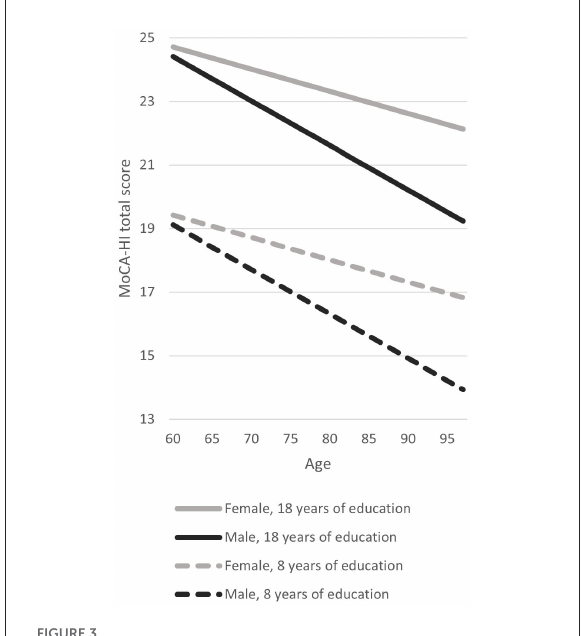
FIGURE3 Example regression lines for the whole study sample ( n = 175) representing the relationship of MoCA-HI total score with age, education and sex. Example regression lines are shown for subjects with 8 and 18 years of education. The regression model shows that the MoCA-HI total score was lower in case of less educational years, an increasing age and in male sex. Age had a stronger effect on the MoCA-HI total score in men than in women. 100 of the subjects included were aged between 60 and 71 years (males n = 59, females n = 41), 60 subjects between 72 and 83 years (males n = 33, females n = 27) and 15 subjects were aged 84 years or older (males n = 7, females n =